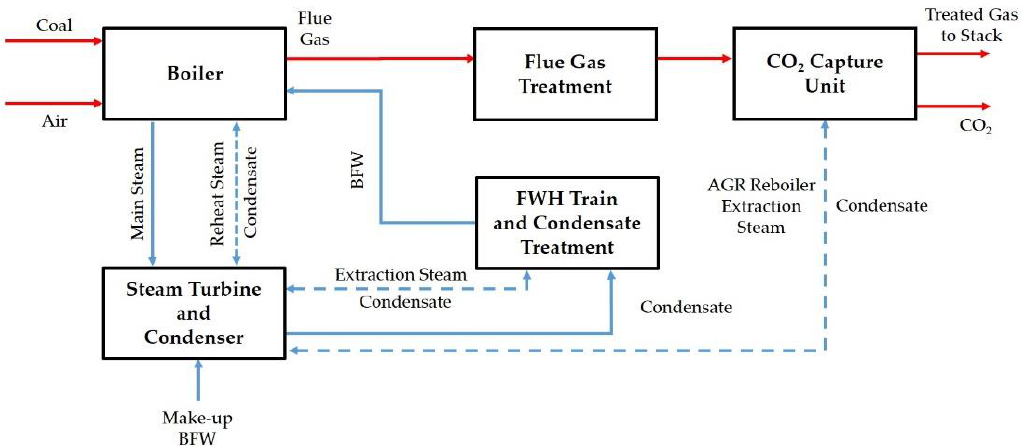
Figure 1. Supercritical Pulverized Coal (SCPC) Power Plant Block Flow Figure 1 . Supercritical Pulverized Coal (SCPC) Power Plant Block Flow Diagram.